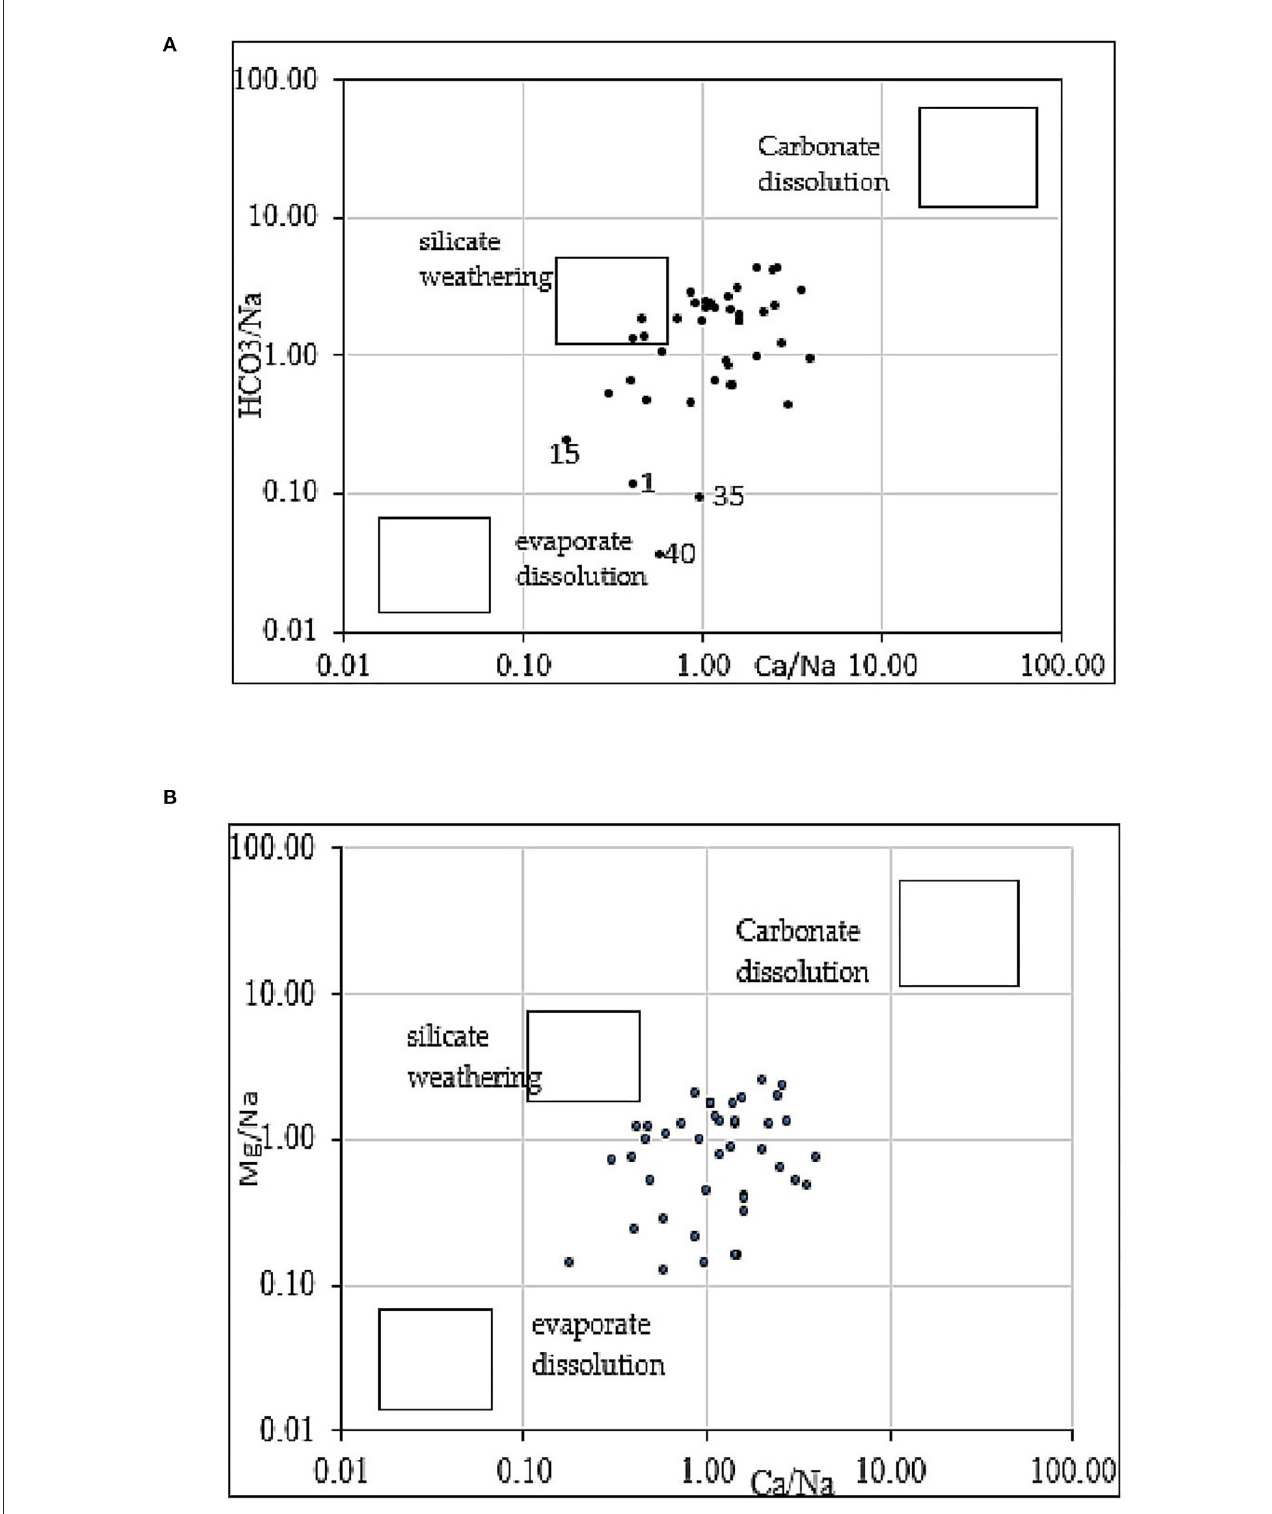
FIGURE7 Bivariate mixing plots of Na-normalize Ca and HCO 3 (A) and Na-normalized Ca and Mg (B) .